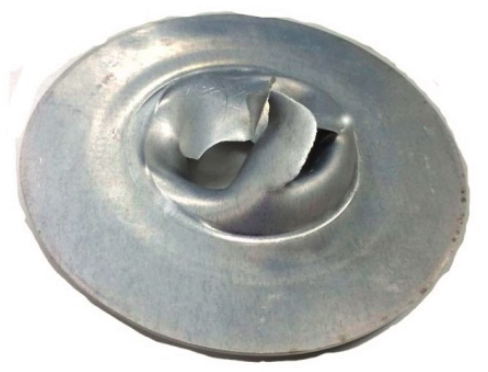
Figure 5. Punctured aluminum sheet.